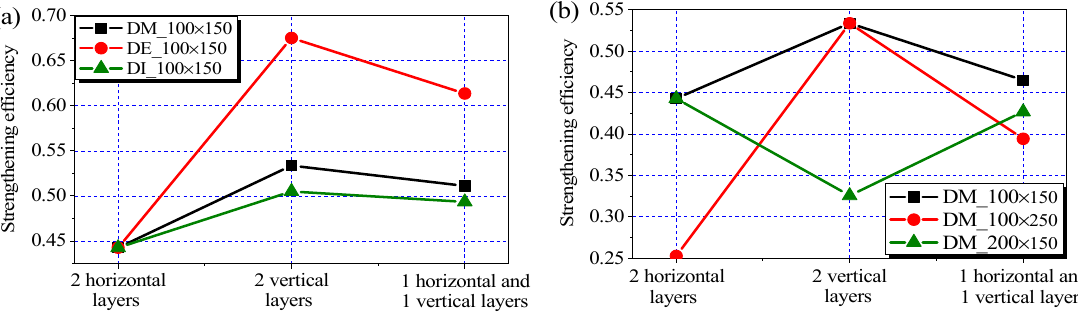
Figure 8. Effect of CFRP layouts. ( a ) Different locations of transverse beam; ( b ) Different cross-section sizes of transverse beam.